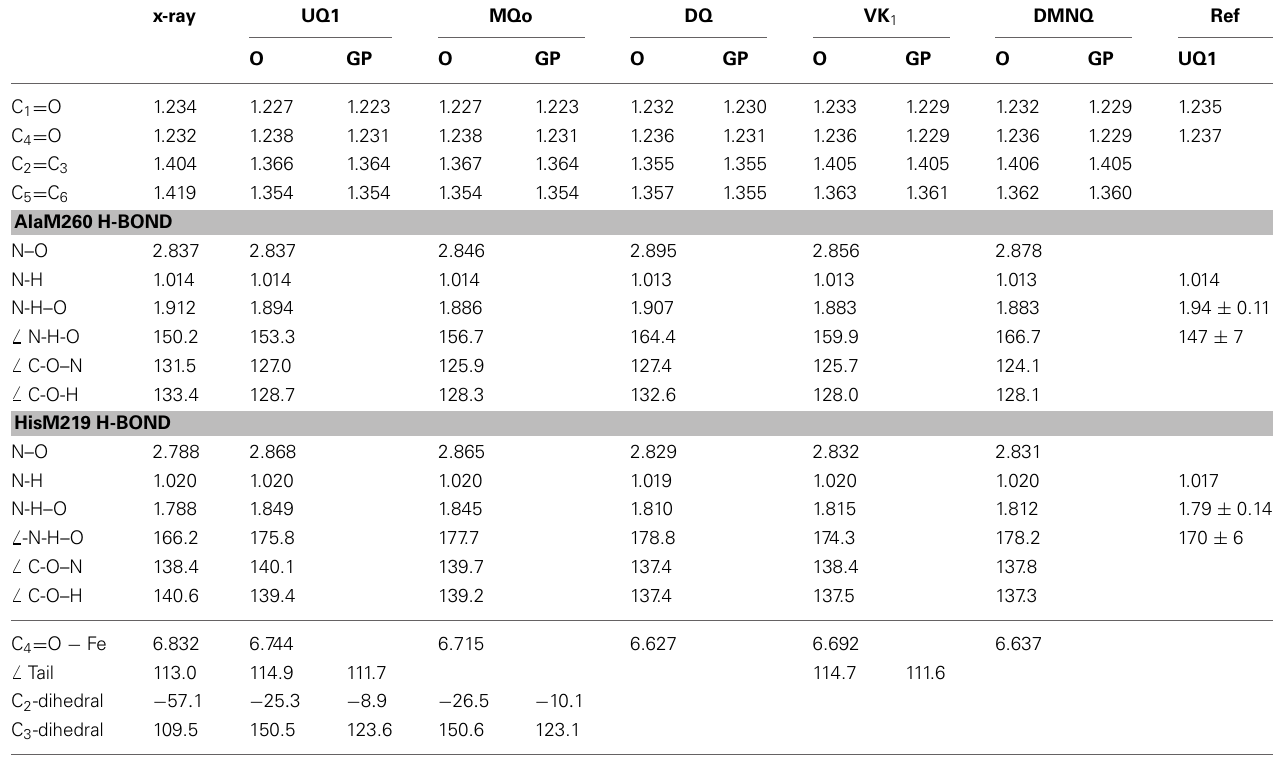
Table 1 | Comparison of bond lengths and angles derived from the ONIOM calculated (O) and gas phase calculated (GP) optimized geometry of neutral UQ 1 , MQ 0 , DQ, VK, and DMNQ.